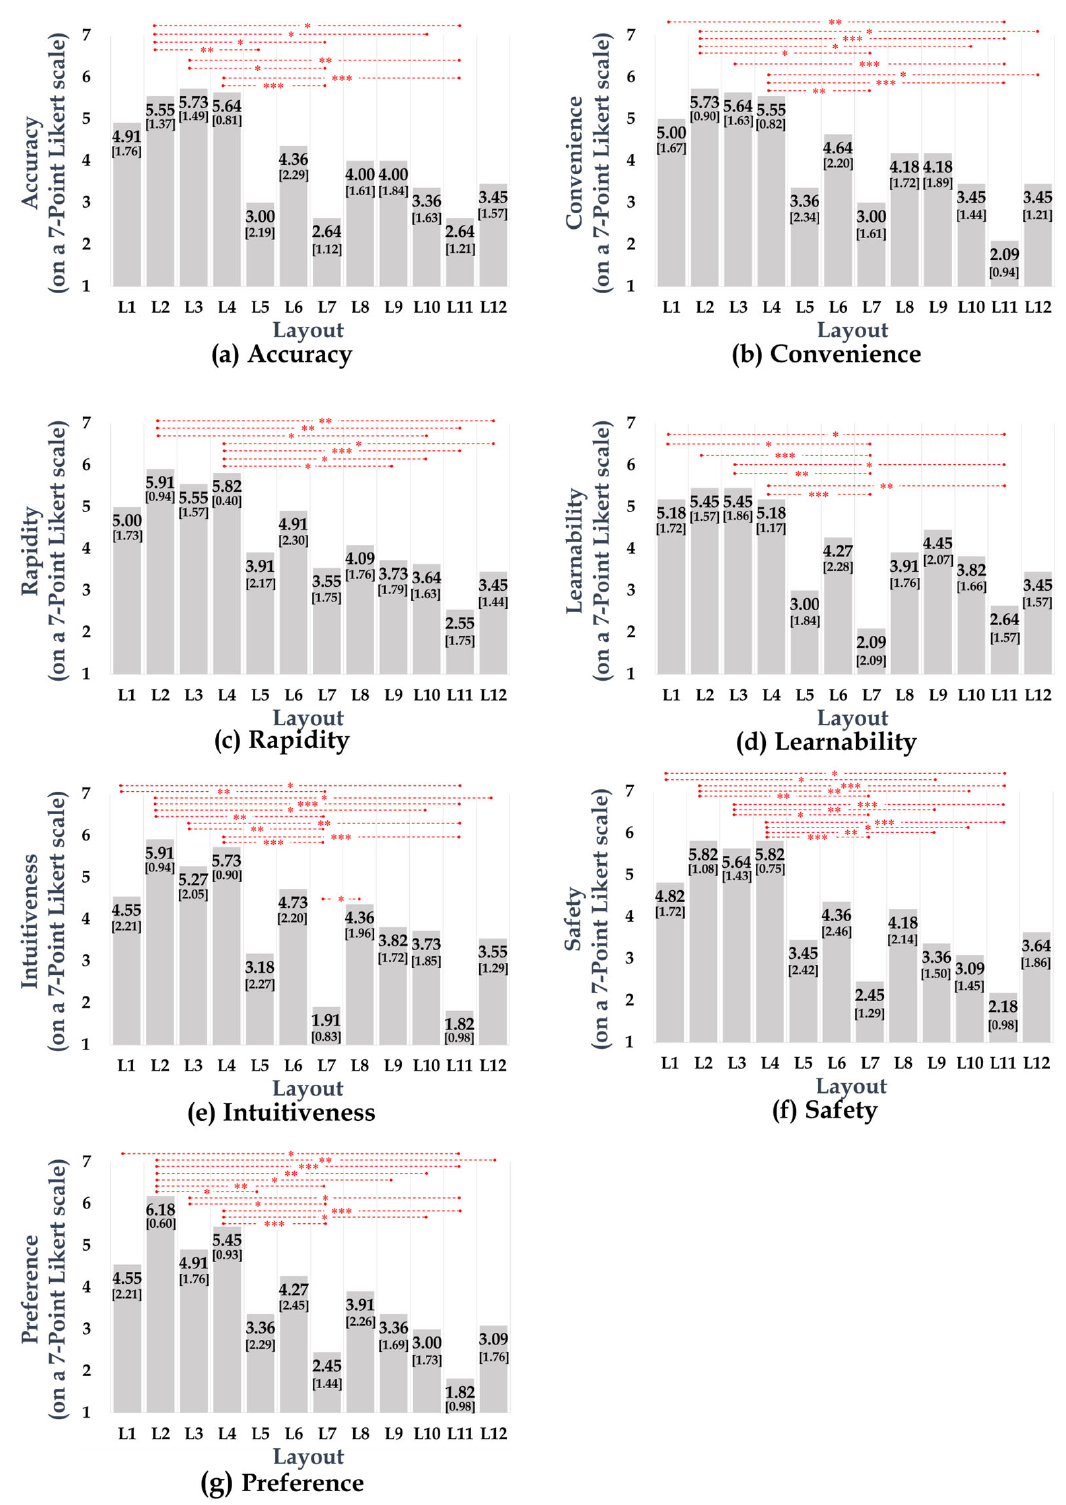
Figure 2. Mean and standard deviation of each subjective rating measure for each layout in the novice driver group: ( a ) accuracy, ( b ) convenience, ( c ) rapidity, ( d ) learnability, ( e ) intuitiveness, ( f ) safety, and ( g ) preference. * p < 0.05, ** p < 0.01, *** p < 0.001.